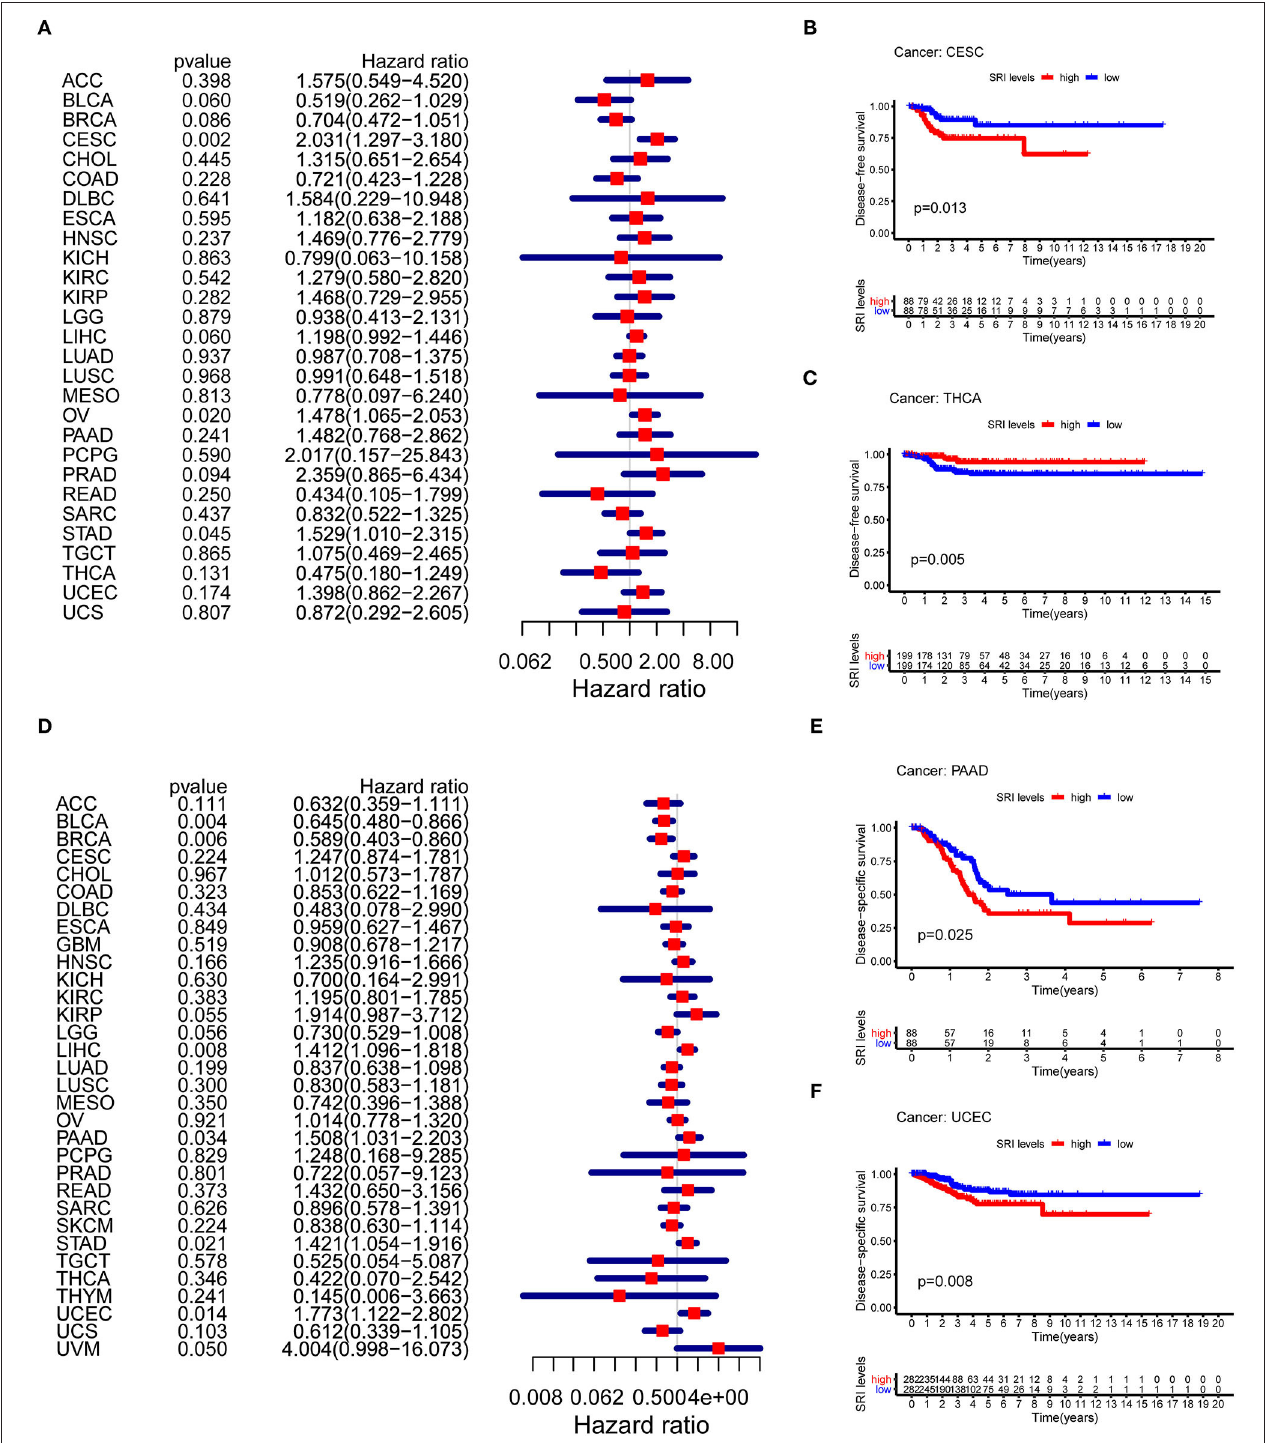
FIGURE 4 | The Cox proportional hazards model and Kaplan–Meier analysis of disease-free survival (DFS) time and disease-specific survival (DSS) by the SRI expression. (A) A forest plot of the associations of SRI expression and DFS in 33 types of tumor (B,C) Kaplan–Meier analysis of the correlations between the SRI expression and DFS. A red line represents the high SRI expression, and the blue lines represent the low SRI expression. (D) A forest plot of the associations of SRI expression and DSS in 33 types of tumor (E,F) Kaplan–Meier analysis of the correlations between the SRI expression and DSS. A red line represents high the SRI expression, and the blue lines represent the low SRI